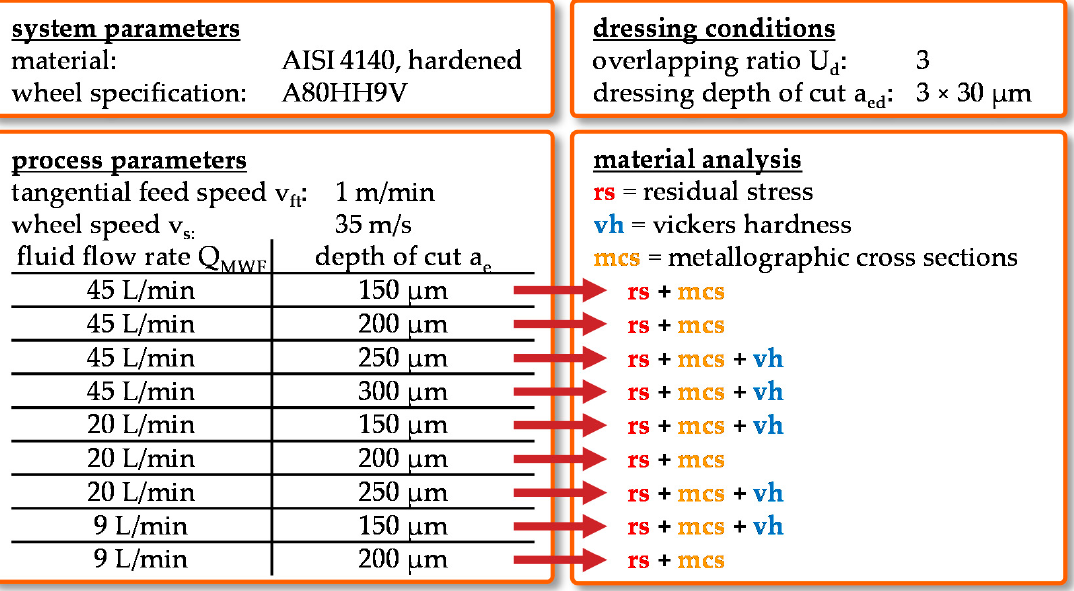
Figure 4. Design of experiments.